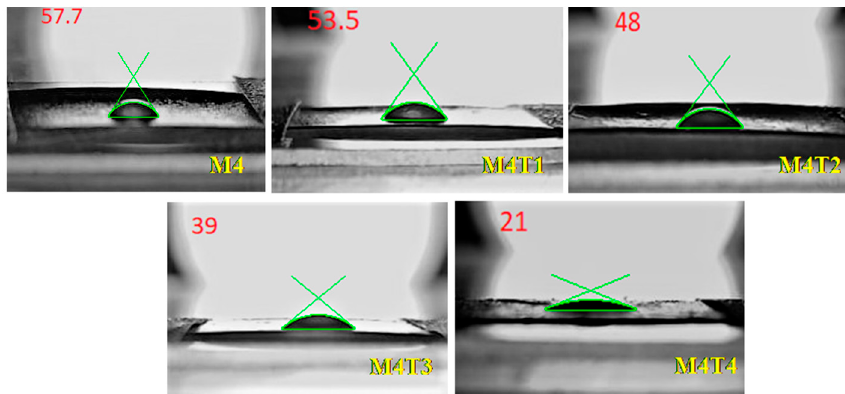
Figure 6. Static water contact angles: M4, M4T1, M4T2, M4T3, and M4T4.